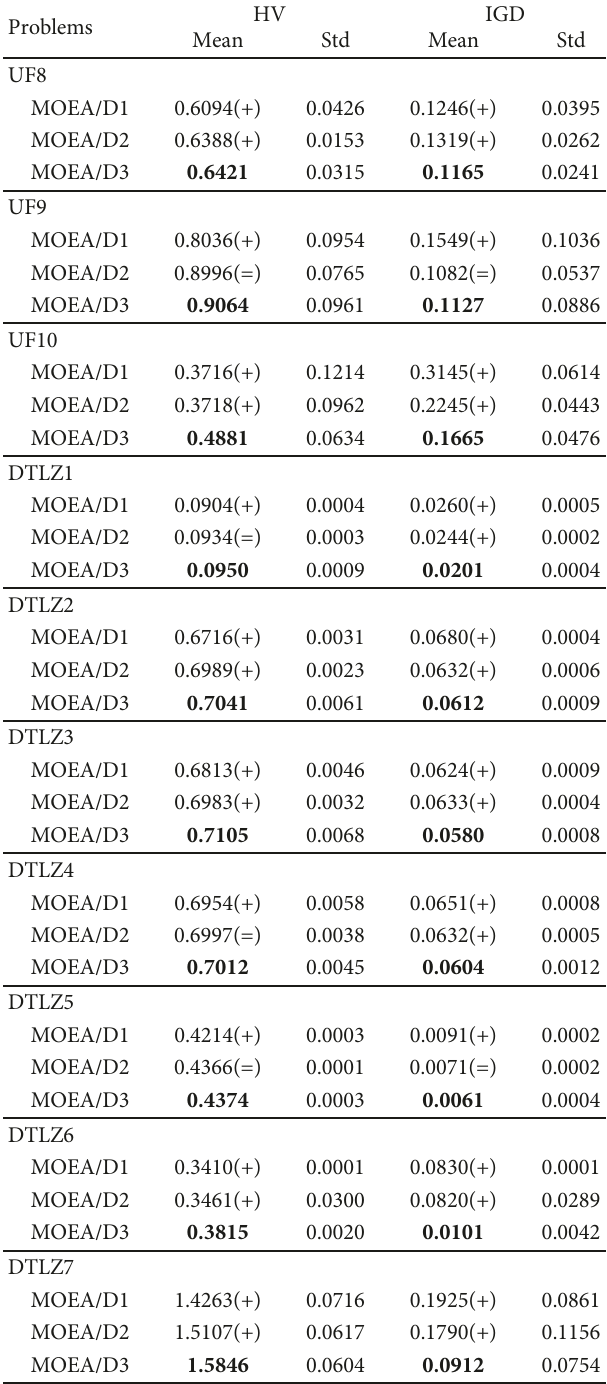
Table 5: HV, GD, and IGD obtained by MOEA/D with three the initialization